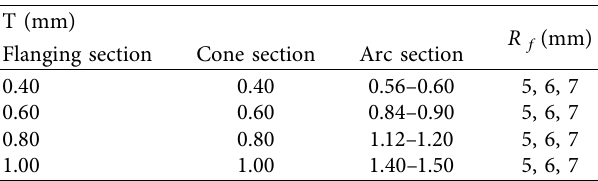
Table 3: Dimensions of the thickness, Tand the chamfering radius, R f for every group. T (mm)